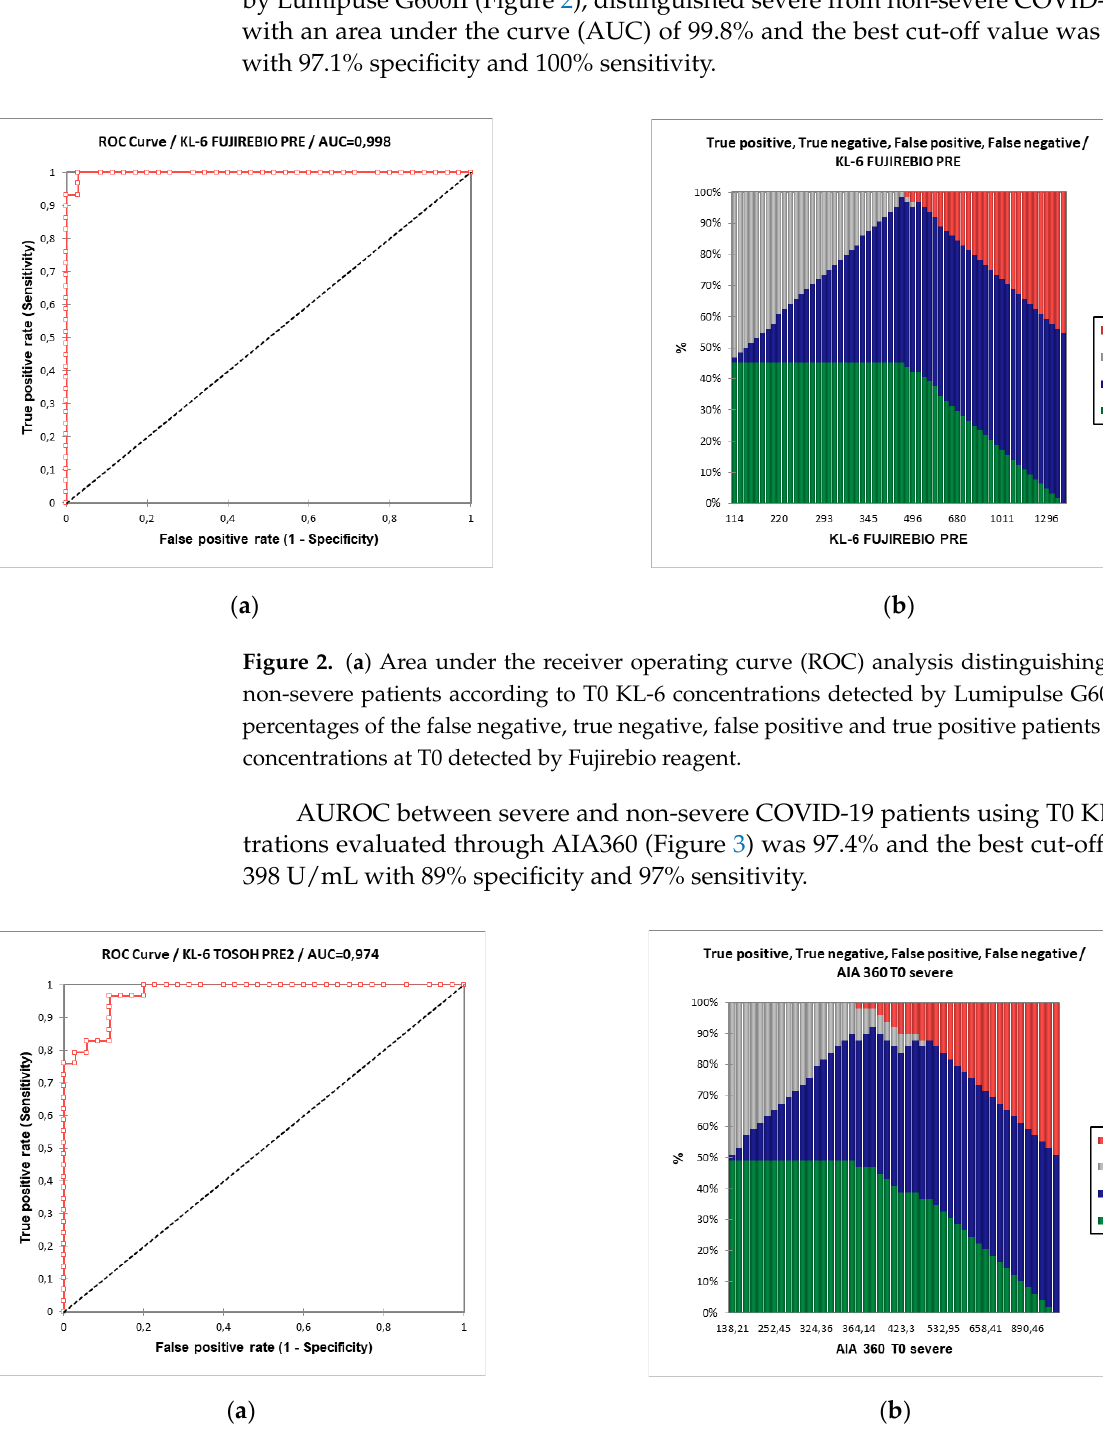
Figure 3. ( a ) Area under the receiver operating curve (ROC) analysis distinguishing severe and non-severe patients according to T0 KL-6 concentrations detected by AIA360. ( b ) The percentages of the false negative, true negative, false positive and true positive patients for the KL-6 concentrations at T0 detected by Tosoh biosciences reagent.